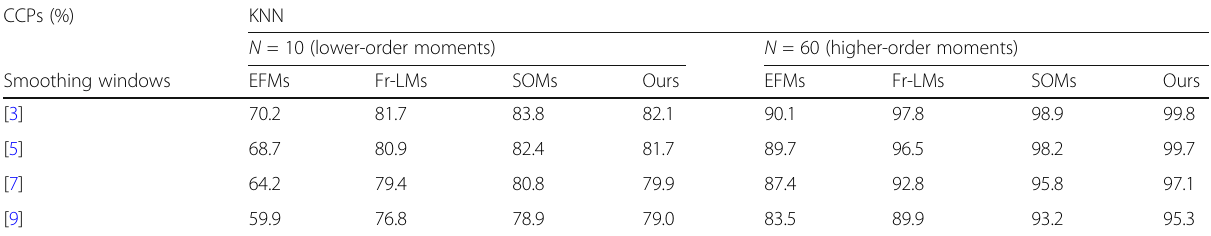
Table 6 Comparative results of the proposed approach and other published methods in recent years for D3 dataset corrupted by smoothing filter